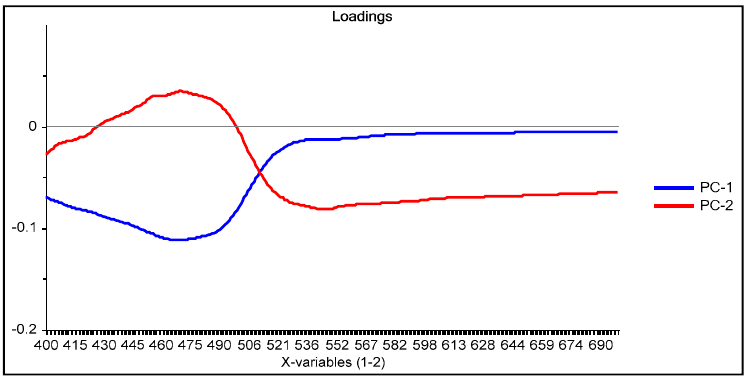
Figure 10. Loadings plot for the M3 processing method in the case of the PAN-Cd(II) PIM optode.